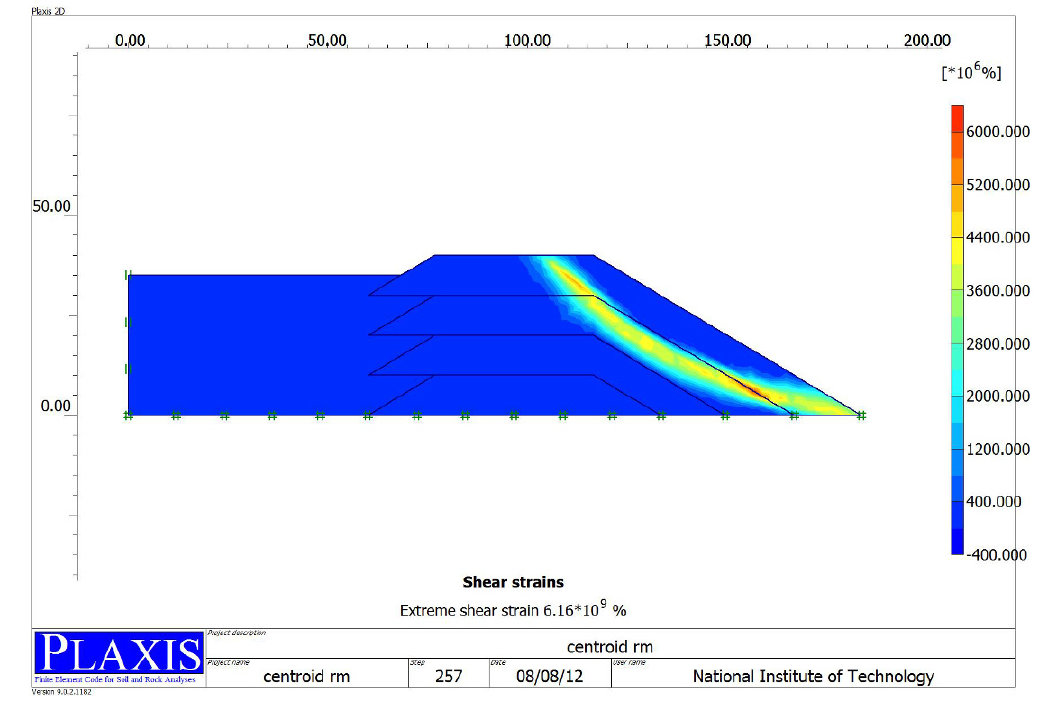
Figure 13. Strain diagram dam in centroid method case showing the failure surface